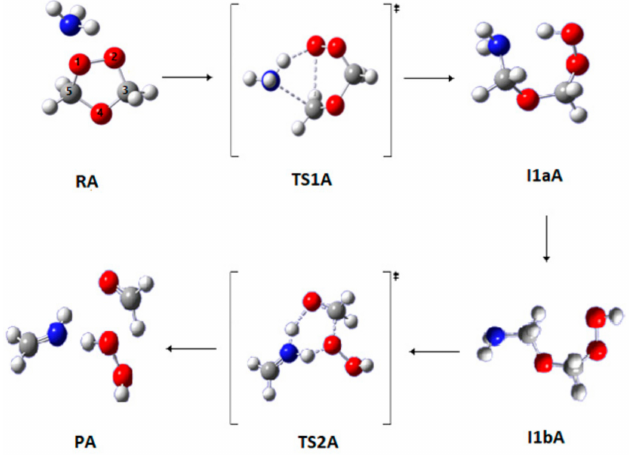
Figure 2. Optimized geometries for the stationary points in Pathway A of the reaction between SOZ and ammonia. Calculated at the APFD / 6-311 ++